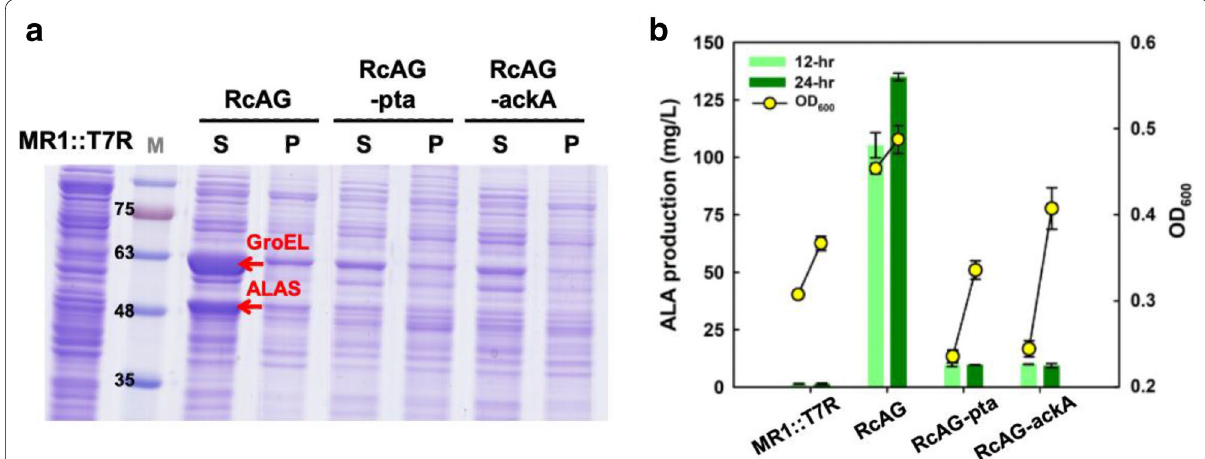
Fig. 5 Co‑expression of ALAS and GroELS in a single plasmid in MR1::T7R with pta and ack A downregulation in MM9 media. a Protein expression was observed by SDS‑PAGE at 12 h. The arrows indicate ALAS and GroEL at sizes of approximately 48 kDa and 63 kDa, respectively. S soluble protein,